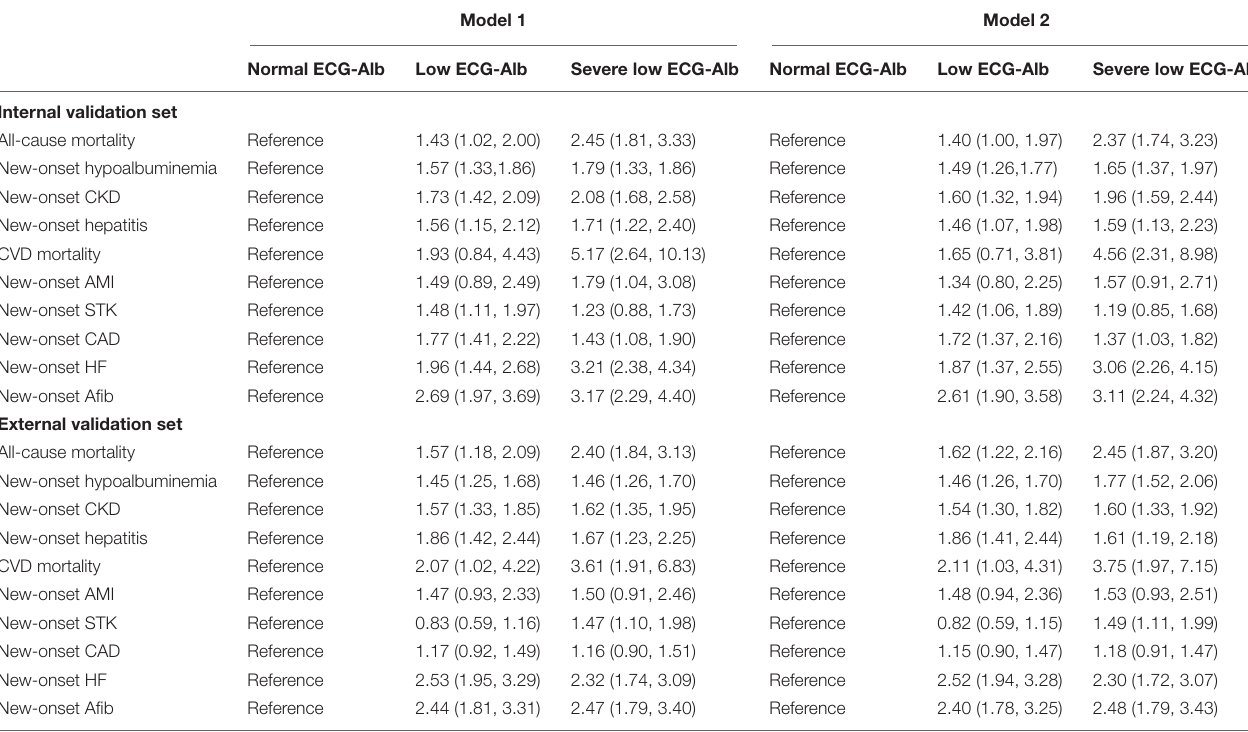
TABLE 2 | Cox proportional hazards model HR and 95% CI Estimates for new-onset hepatorenal and cardiovascular events in different adjustment